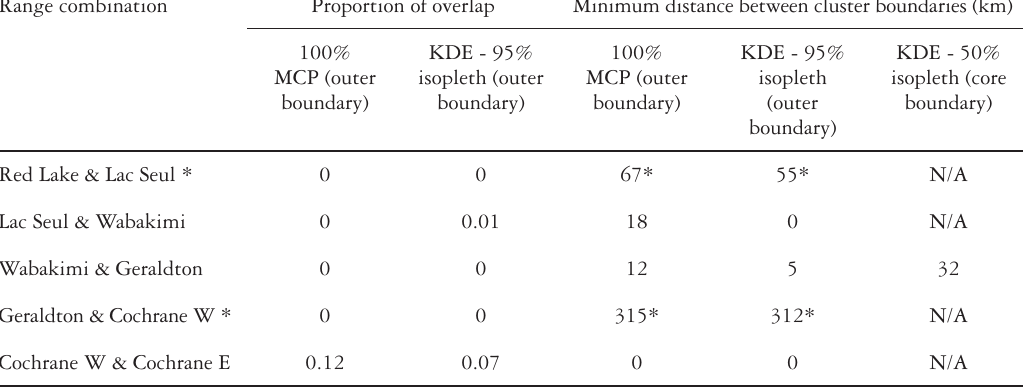
Table 1. Proportion of overlap and minimum distances between outer boundaries (100% Minimum Convex Polygon and kernel density estimate-based) and core area boundaries (kernel density estimate-based) of adjacent clusters. For situations where minimum distances between the outer boundaries of adjacent clusters may be exagger- ated due to incomplete sampling, the corresponding ‘Range combination’ and ‘Minimum distance’ fields are identified by an ‘ * ’. For clusters where available data was determined to be insufficient for obtaining reliable estimates of core use areas (i.e., Red Lake, Lac Seul and Cochrane West), core boundaries were not delineated and distances between cores are listed as ‘N/A’ in the